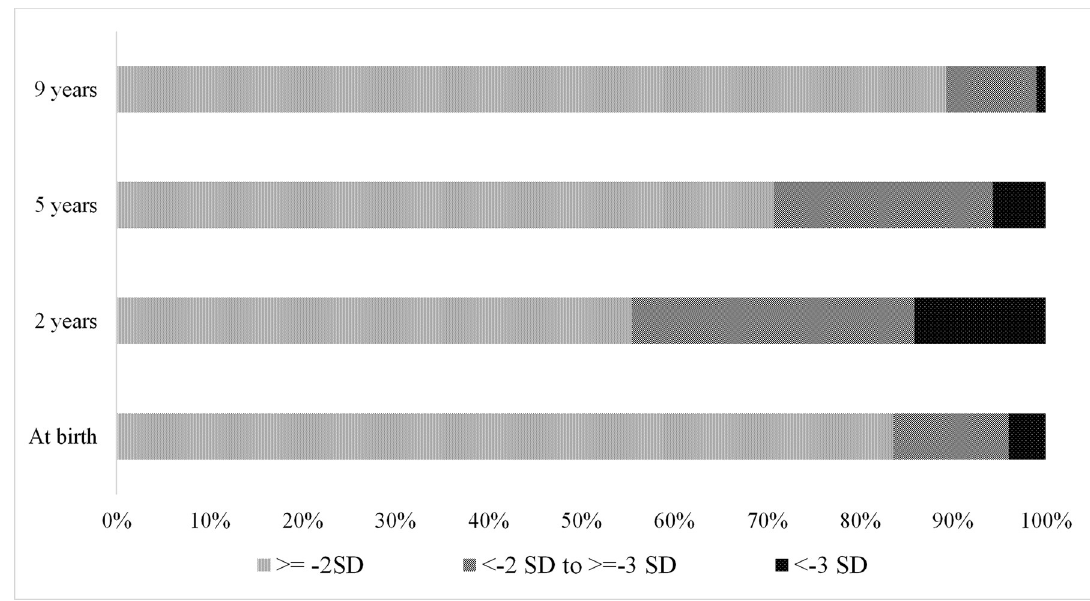
Fig 2. Proportion of children stunted at 0, 2, 5 and 9 years of age in MAL-ED